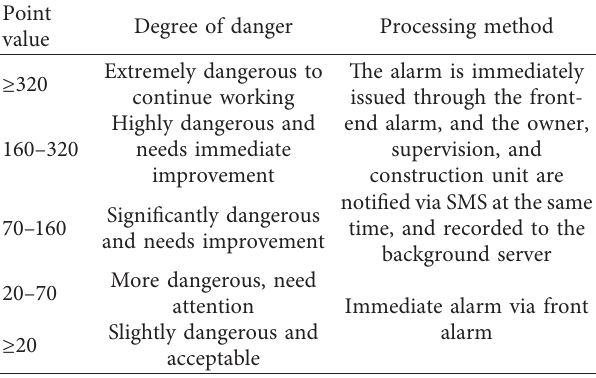
Table 4: Classification and treatment of danger levels (R).